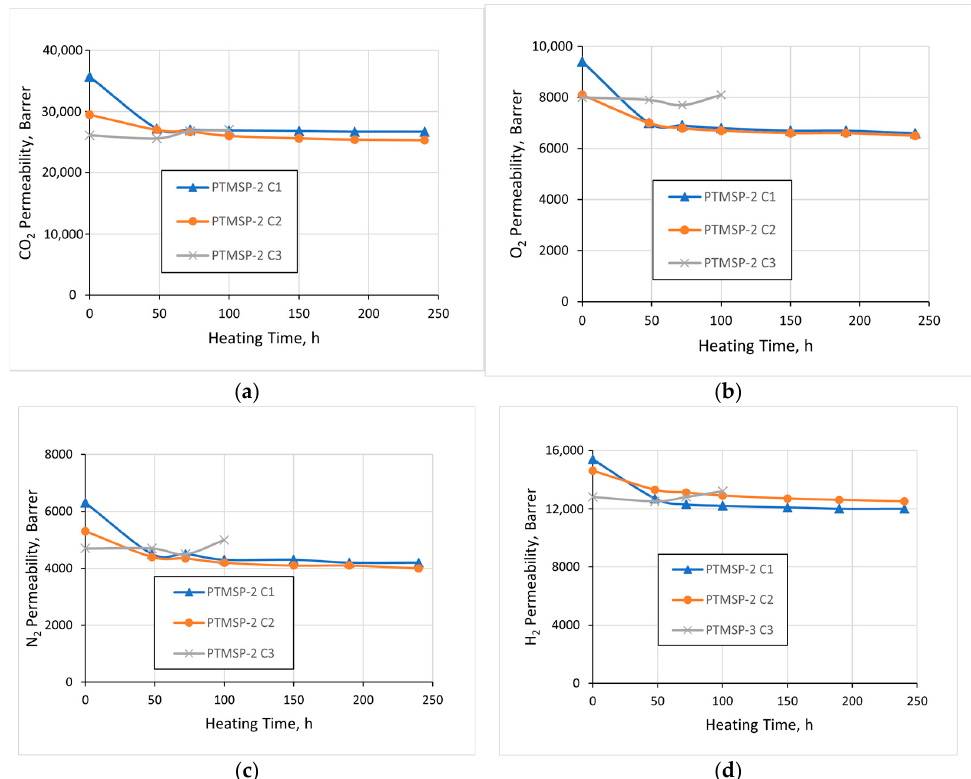
Figure 4. Gas permeability coefficients vs. heating time for the films of PTMSP-2 containing